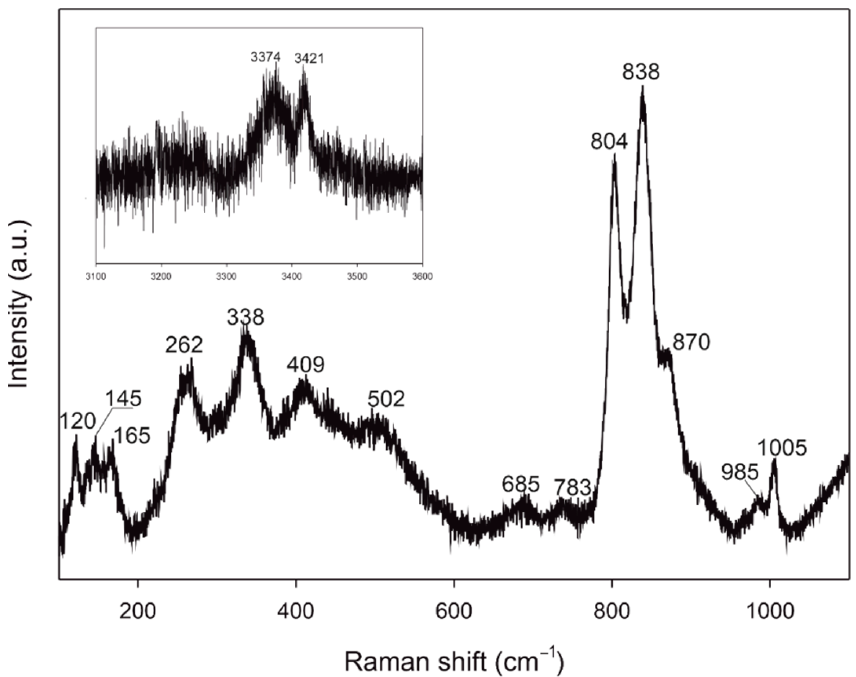
Figure 3. The Raman spectrum of Cd 5 (VO 4 ) 2 (OH) 4 between 100 and 1100 cm –1 and the section between 3100 and 3600 cm –1 showing the OH stretching region.